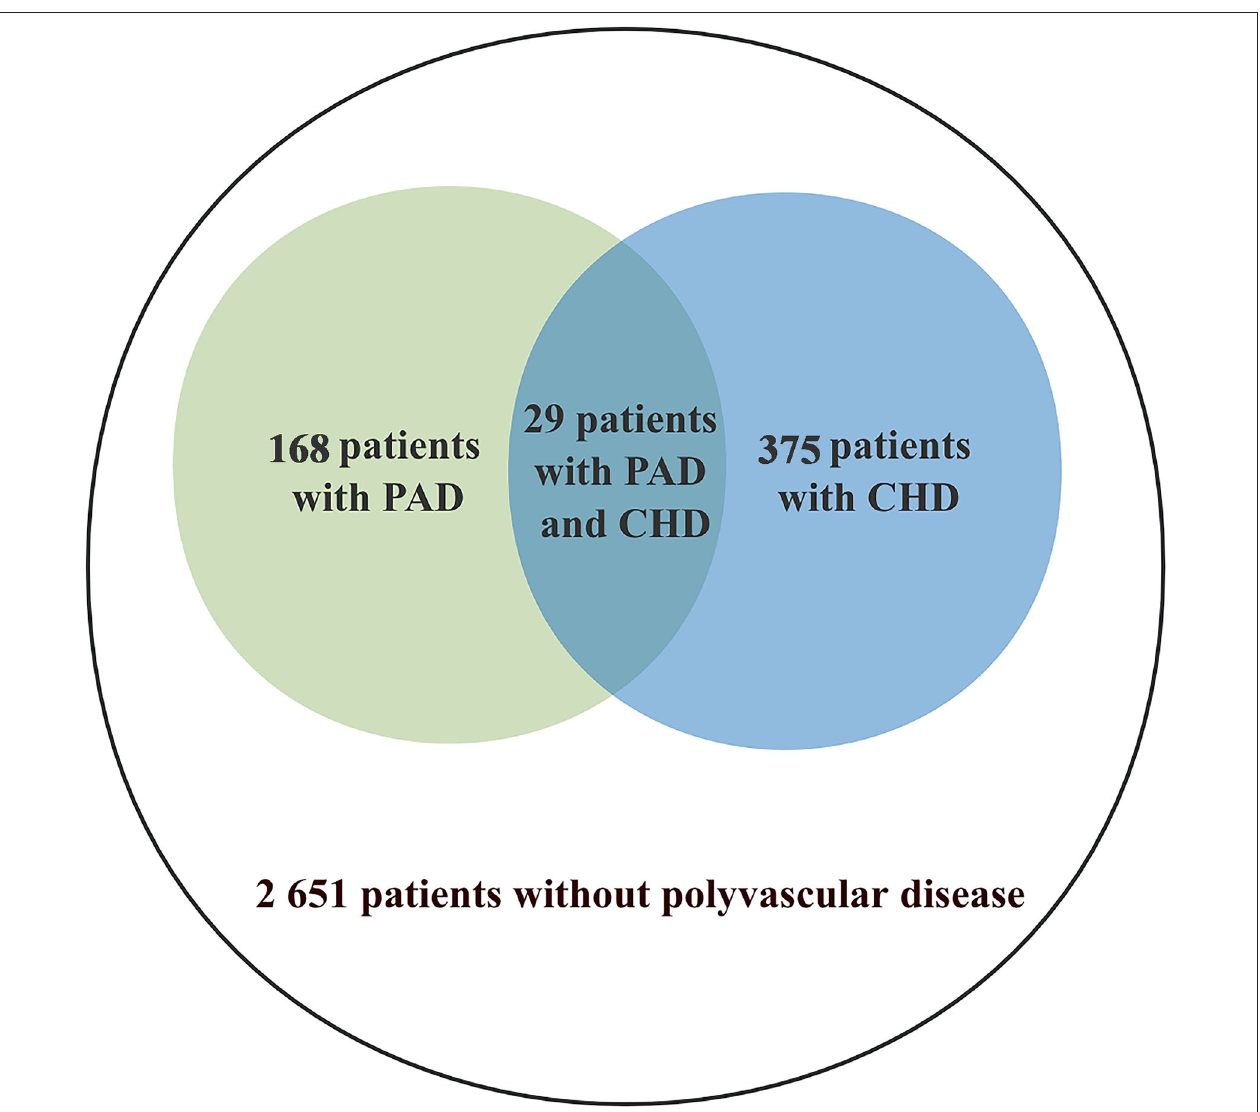
FIGURE 1 | Study population and